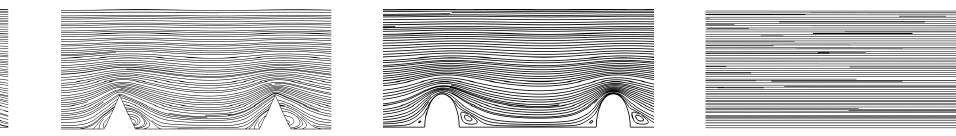
Figure 24. The mixing indices of three mixers with ( a ) square rough element, ( b ) triangular rough element and ( c ) elliptical rough element under different Re values.